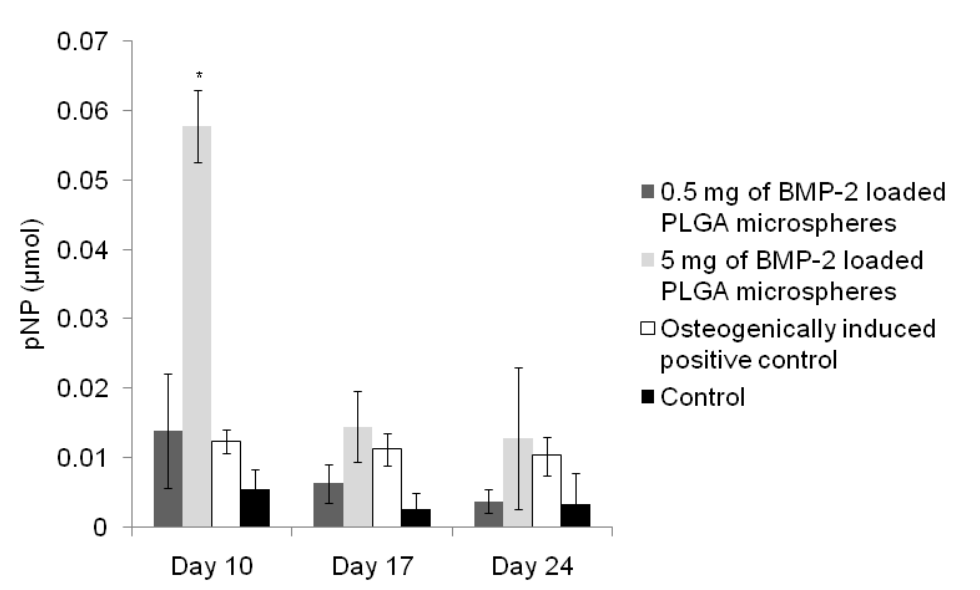
Figure 5. Quantification of ALP expression at day 10, day 17 and day 24 by MC3T3-E1 cells cultured under 4 different conditions: 0.5 mg of BMP-2 loaded PLGA/PLGA-PEG-PLGA microparticles, 5 mg of BMP-2 loaded microparticles, control media (no microparticles) and an osteogenic media (positive control, no microparticles). Error bars show ± 1 SD (n = 4) *p ≤